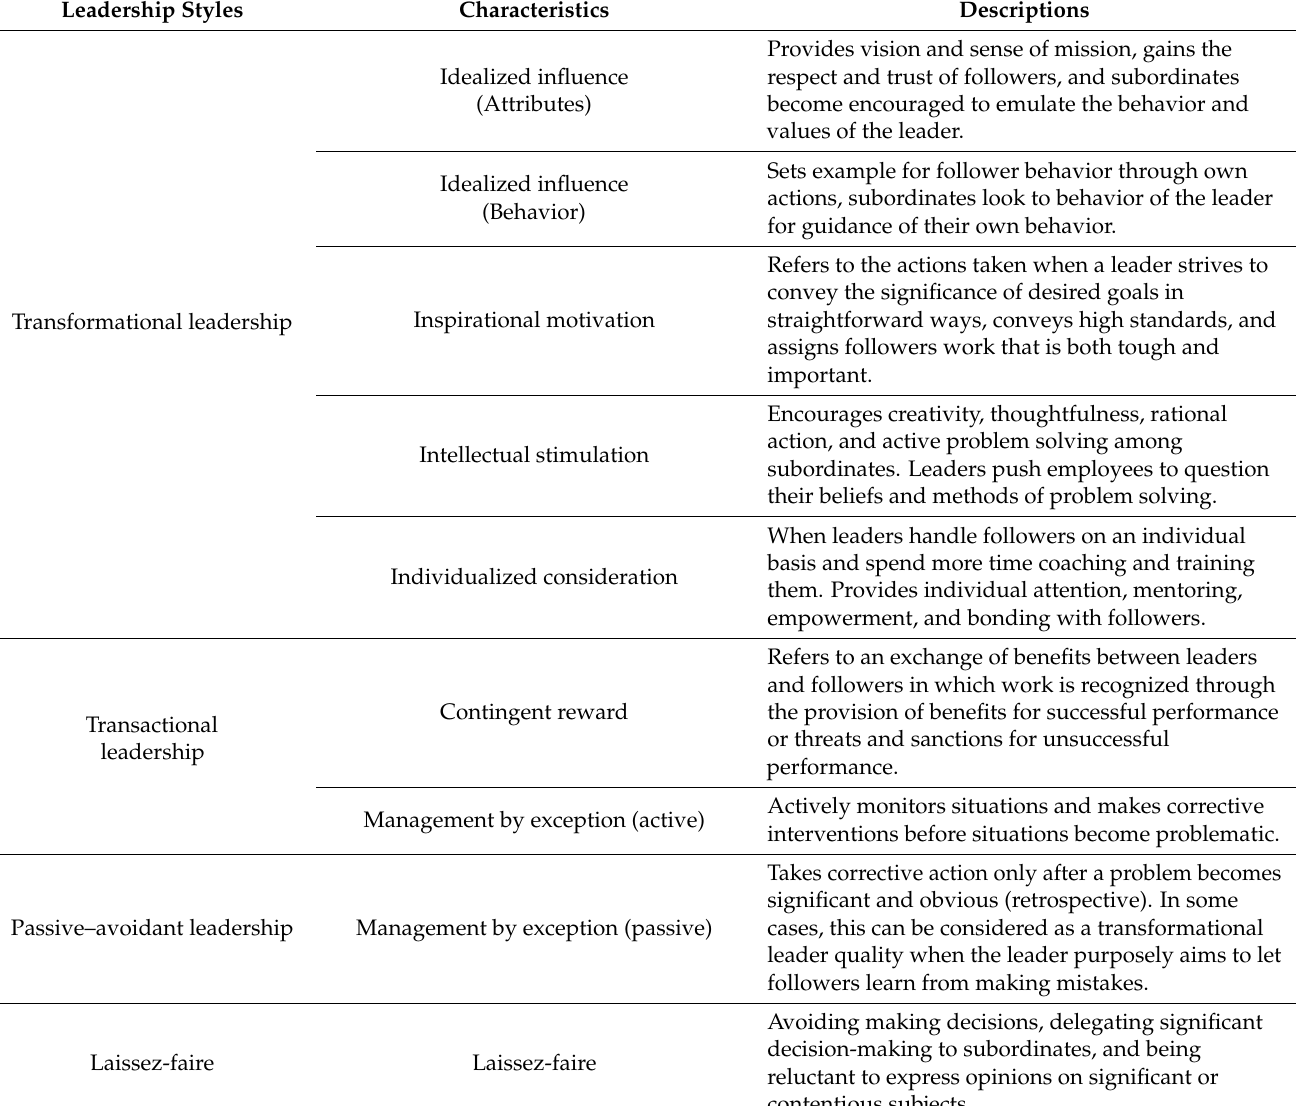
Table 1. Summary of the basic leadership styles and their